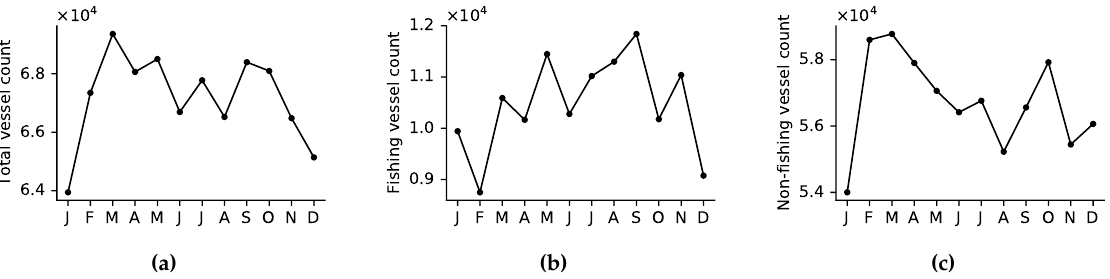
Figure 11. Vessel count (2017) after correction for variation in the number of Sentinel-1 images for the ( a )